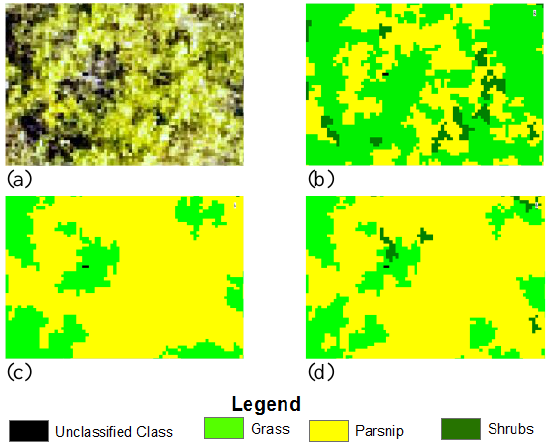
Figure 8. Detailed 0.02m RGB+2 Image Classification Results for a small subset (a) Raw UAV image, (b) ML, (c) SVM, (d) RF